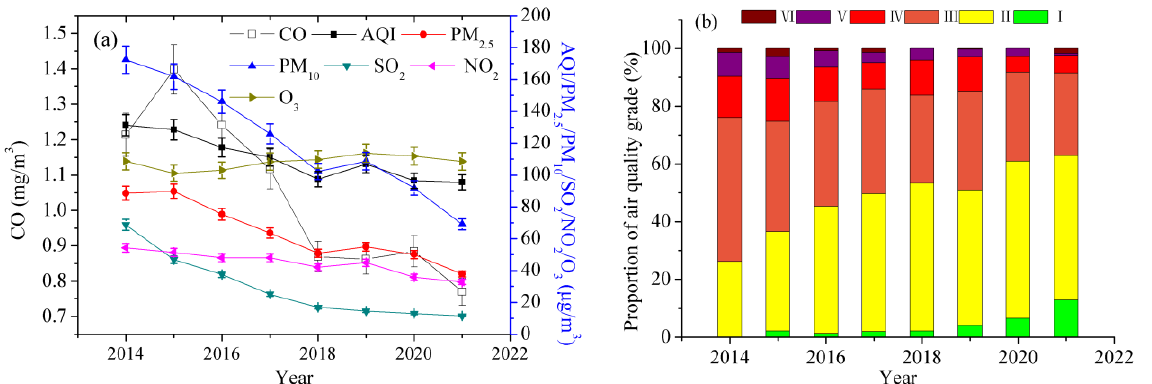
Figure 1. Interannual variations in air quality in Jinan City during 2014–2021.( a ) the annual average concentrations of PM 10 , PM 2.5 , NO 2 , SO 2 , CO, and O 3 and AQI values; ( b ) the proportions of AQI ranks.